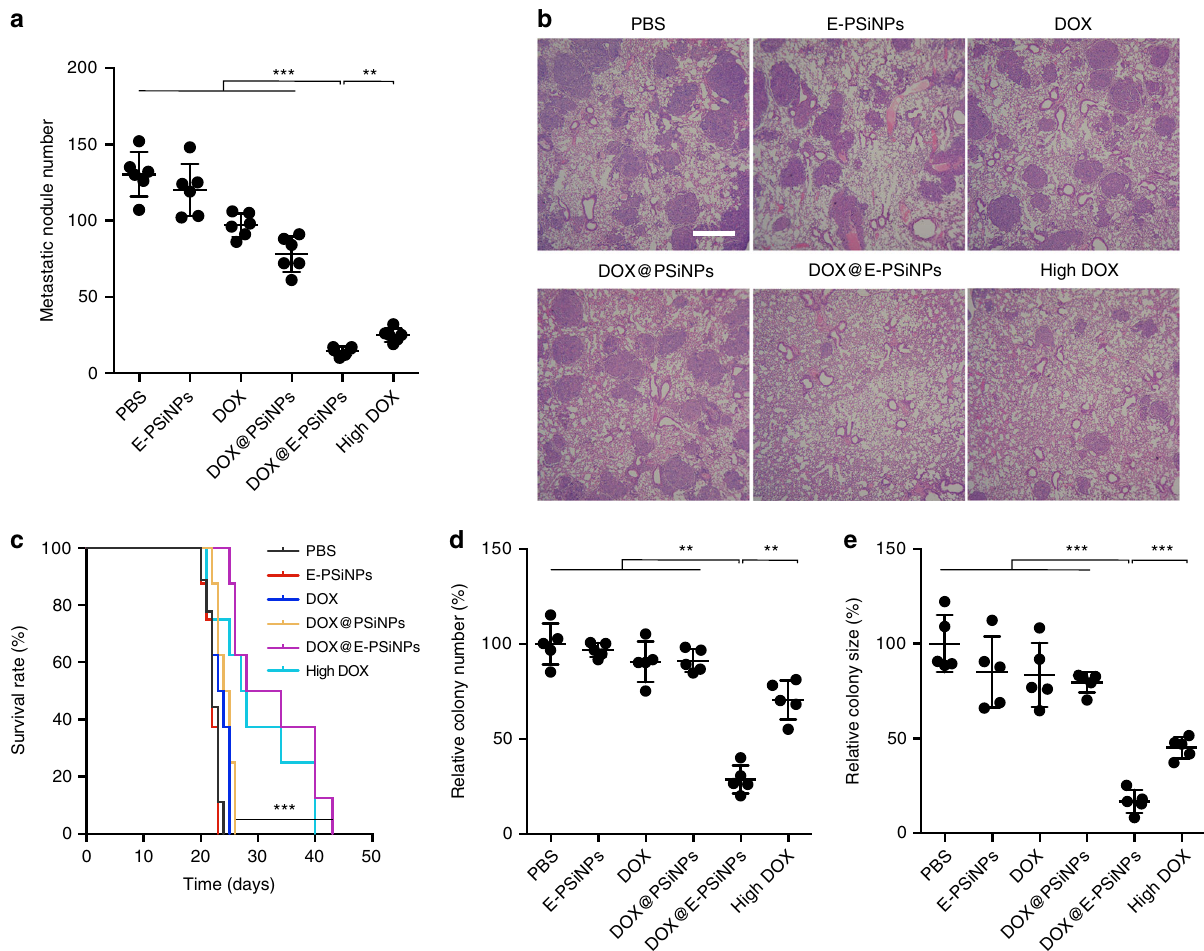
Fig. 9 Anticancer activity of DOX@E-PSiNPs in B16-F10 lung metastasis mice. a Metastatic nodule numbers in lungs of B16-F10 tumor-bearing mice after intravenous injection of PBS, E-PSiNPs, free DOX, DOX@PSiNPs, DOX@E-PSiNPs exocytosed from H22 cells at DOX dosage of 0.5 mg kg − 1 , or free DOX at high dosage of 4 mg kg − 1 every three days for 13 days. Data were represented as mean ± SD ( n = 6). b H&E staining of lungs of B16-F10 tumor-bearing mice at the end of tumor growth inhibition experiments. Scale bar: 1000 µ m. c Kaplan – Meier survival plot of B16-F10 tumor-bearing mice after intravenous administration of different formulations ( n = 8). d , e Relative colony number ( d ) and size ( e ) of tumor spheroids when tumor cells digested from lung tumor nodules at the end of tumor growth inhibition experiments were seeded in soft 3D fi brin gels for 5 days. Data were represented as mean ± SD ( n